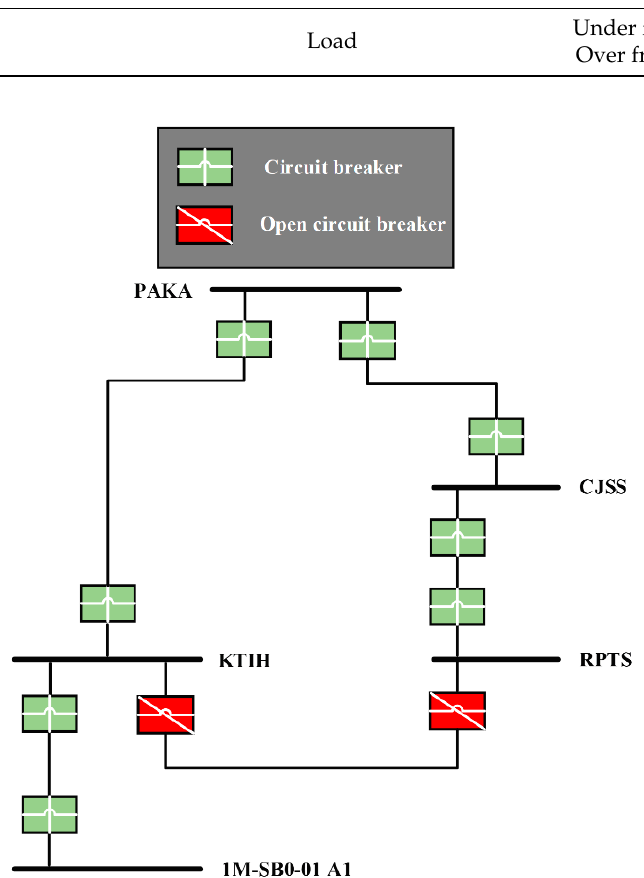
Figure 3. Islanding Scenario 1 of the test system.